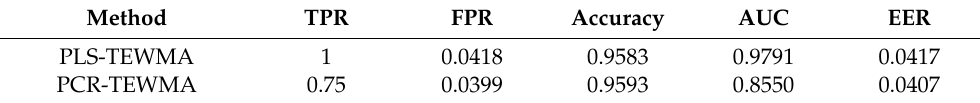
Figure 14. Detection results of ( a ) PLS- and ( b ) PCR-based TEWMA charts in the presence of inverter disconnections. Table 4. Results of PLS- and PCR-based TEWMA charts under inverter disconnections. Method